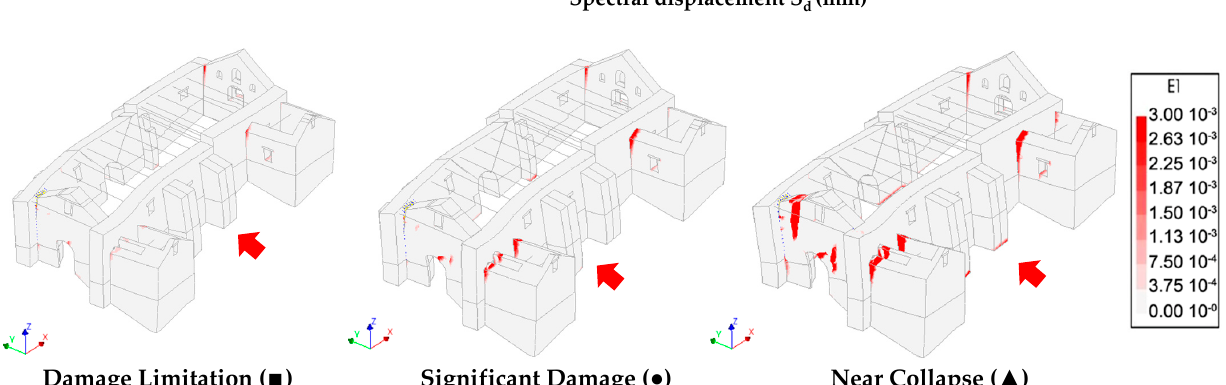
Figure 25. Damage Limitation (solid black line), Significant Damage (dotted black line) and Near Collapse (dash-dot black line) elastic demand spectra and bilinearized SDOF capacity diagrams indicating the target displacements ( ∎ , ● , ▲ ) in the +YY direction. The distribution of maximum principal plastic strains corresponding to the attainment of the target displacement at each performance level is shown in the contour diagrams.